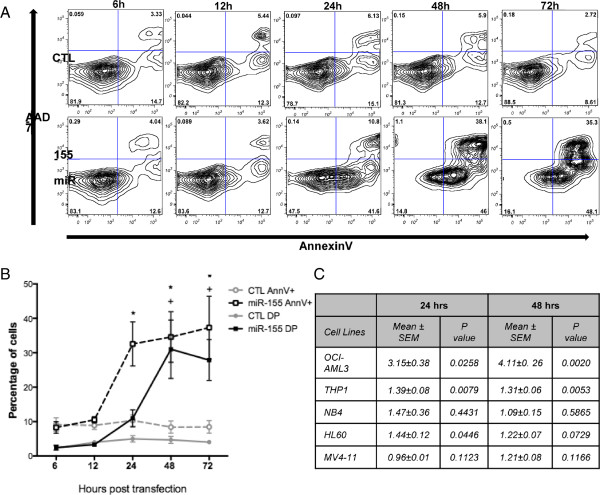
Induction of apoptosis of OCI-AML3 cells after miR-155 transfection. (A) Gating strategy for flow cytometry analysis. Cells undergoing early apoptosis are stained for AnnexinV, cells undergoing late apoptosis are stained for both AnnexinV and 7-AAD (B) increase in AnnexinV positive cells (dashed line) or Double Positive cells for AnnexinV/7-AAD (solid line) post transfection with miR-155 (black line) compared to CTL (grey line) (C) summary of fold-change of cells (OCI-AML3, THP1, NB4, HL60, MV4-11) binding AnnexinV overexpressing miR-155 normalised to CTL at 24 and 48 hours post transfection. AnnV + AnnexinV positive cells; DP- double positive cells, CTL- Scrambled control. Statistical significance determined using Paired Two Tailed t-Test, *p < 0.05 of AnnV + cells; +p < 0.05 of DP cells, n = 4-7.